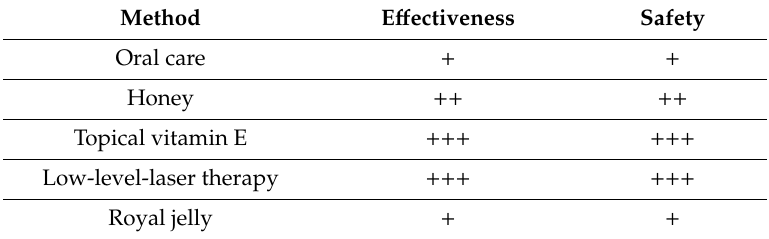
Table 4. Suggestions regarding treatment of chemotherapy-induced oral mucositis.